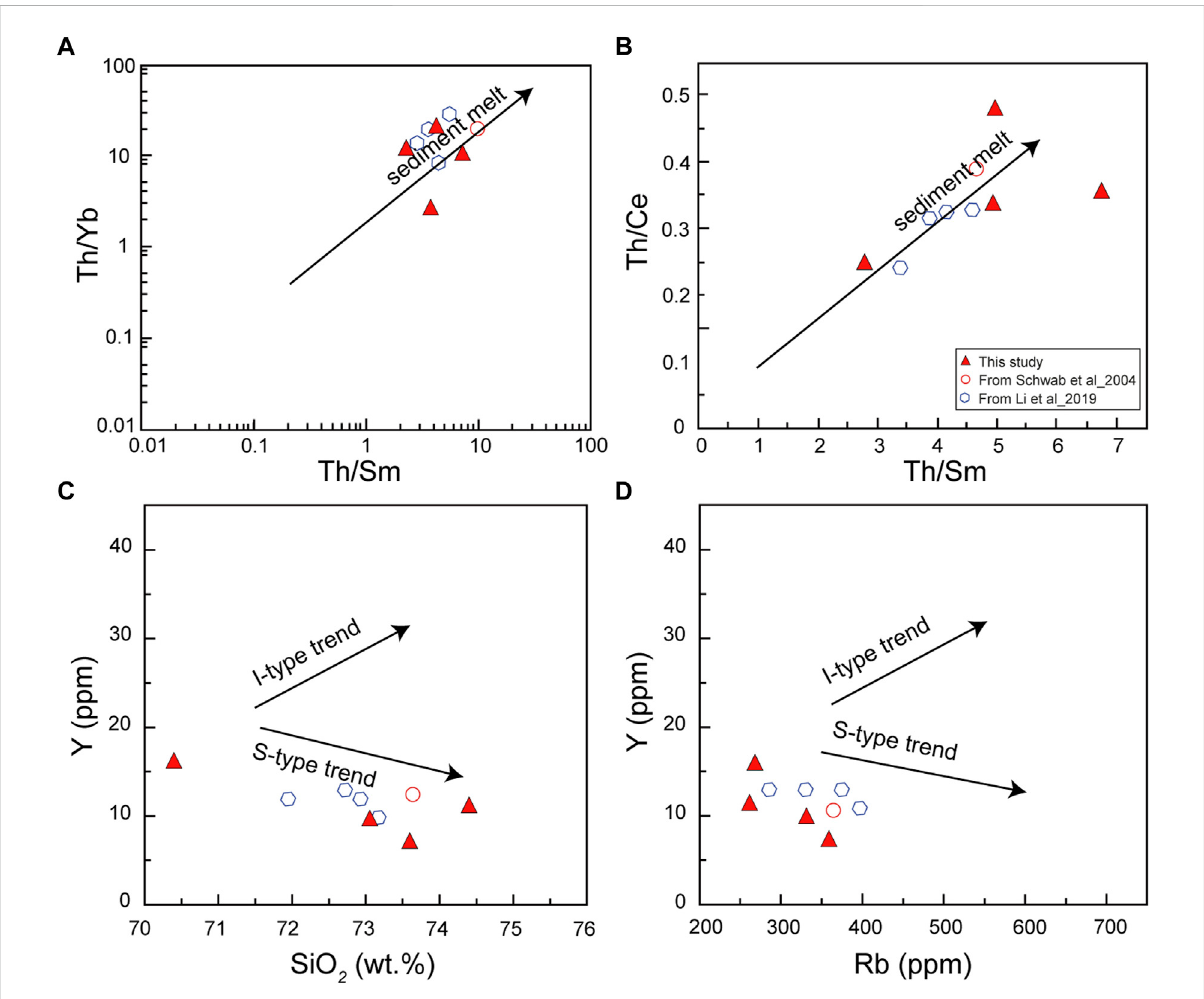
FIGURE 8 (A) Th/Yb vs.Th/Sm, (B) Th/Cevs. Th/Sm, (C) Y vs.SiO 2 , and (D) Y vs. Rb(Chappell, 1999). The data arefrom thisstudy, Schwab etal. (2004),and Li R. H. et al.